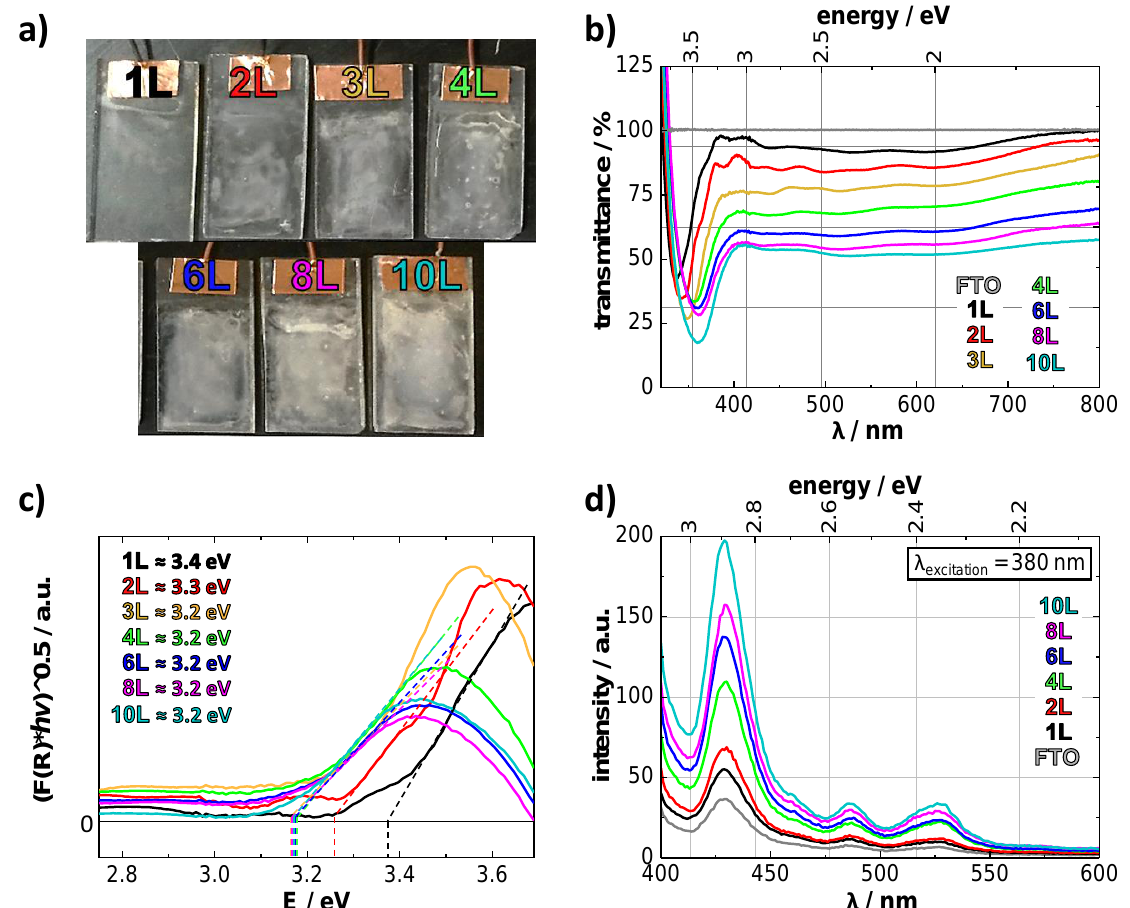
Figure 6. Photograph and optical spectra of multi-layered MTTFs calcined at 550 ◦ C. ( a ) Photographs of selected samples, ( b ) UV/Vis transmittance spectra, ( c ) Tauc plots, and ( d ) fluorescence